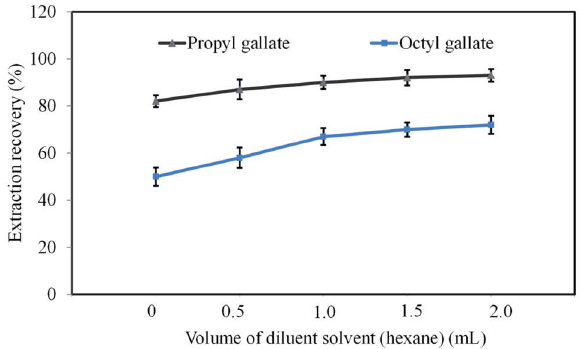
Figure 4. Effect of the volume of diluent solvent. DES, ChCl:ethyl- ene glycol; diluent solvent, n -hexane; DES volume, 100 µL; vortex time, 5